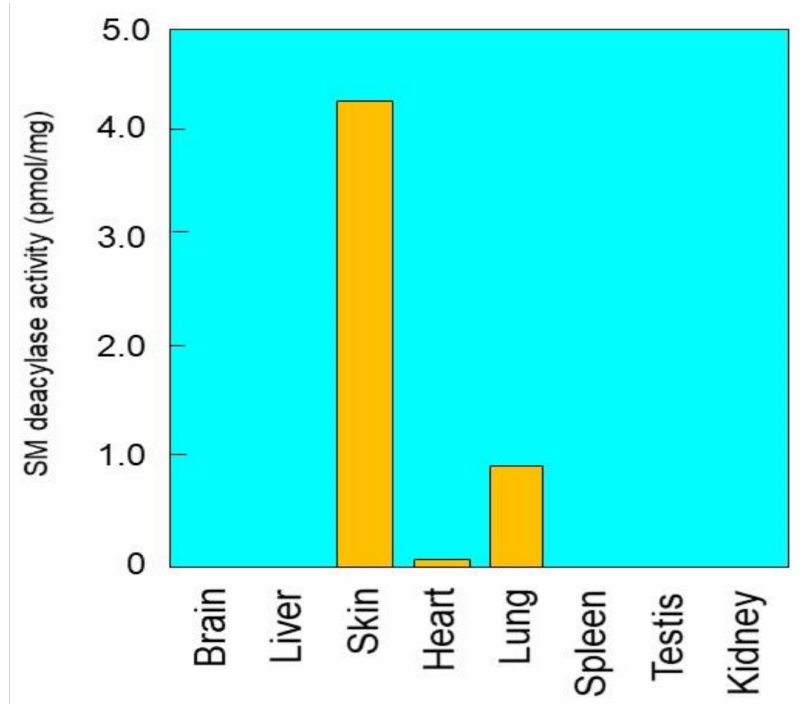
Figure 1. Distribution of sphingomyelin (SM) deacylase activity in rat tissues. SM deacylase solubilized by 1% n-octyl- β - d -glucoside from various rat tissues was incubated with 20 µ M SM at 37 ◦ C for 16 h. The reaction product (sphingosylphosphorylcholine, SPC) was quantified according to assay procedures as described in the Section